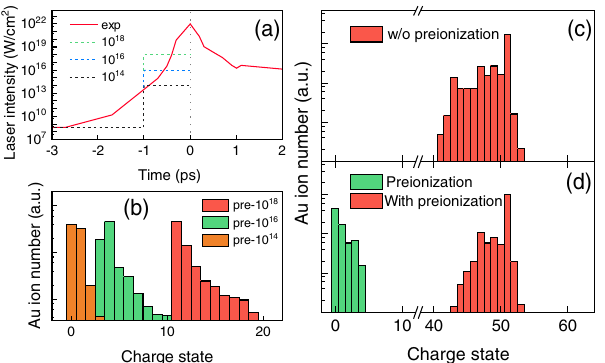
FIG. 9. (a) Temporal profile of the laser pulses after the double- plasma mirrors (red line), and the assumed 1-ps pedestal with different intensity (dashed lines). (b) Charge-state distribution before the arrival of the main pulse. (c) Final charge-state distribution without preionization. (d) Charge-state distribution before (green bars) and after the main pulse, considering the preionization caused by the rising edge of the laser pulse (red